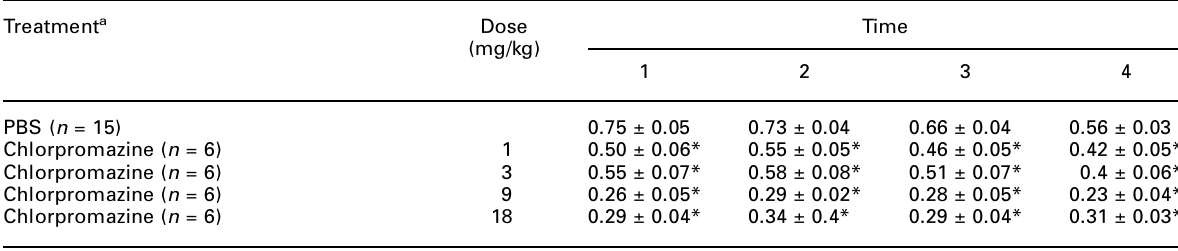
Table 4. Effect of chlorpromazine (anti-TNF/5-HT 2 ) on the time course of paw oedema induced by OVA in sensitized rats Treatment